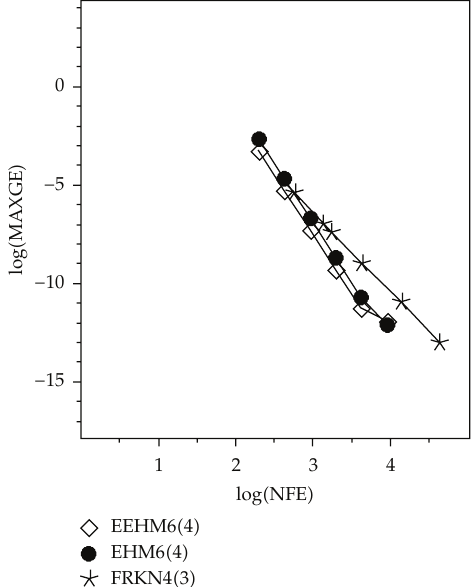
Figure 4: E ffi ciency curves for Problem